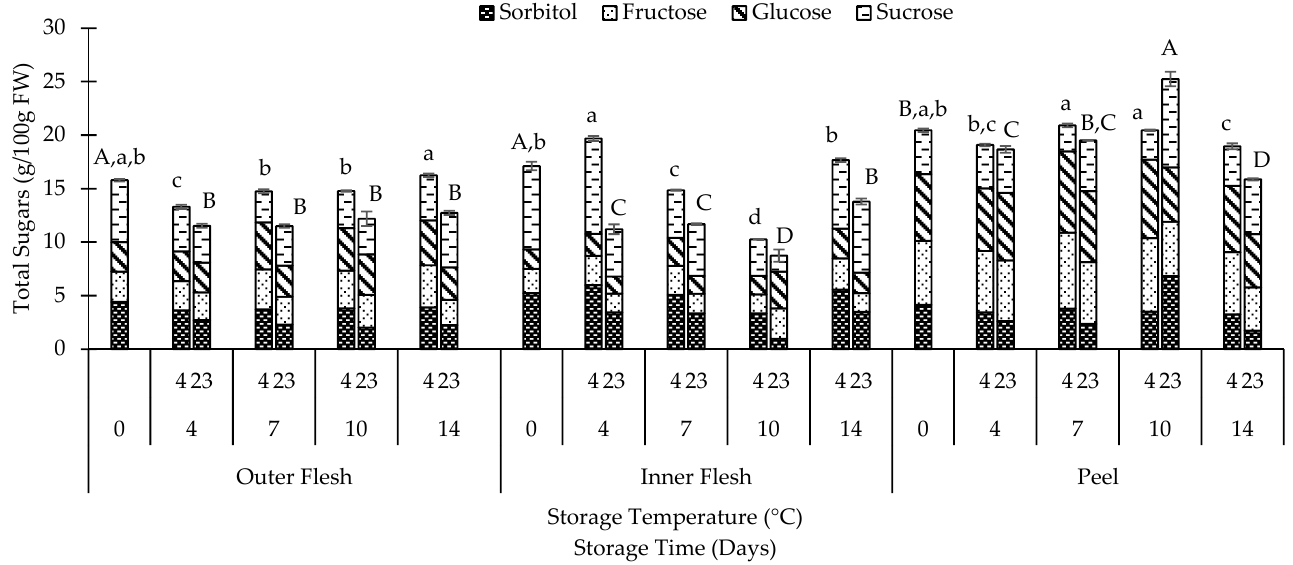
Figure 6. Total sugars (mean ± SE) and individual sugars (mean) in different QGP tissues ( n = 3). Different uppercase letters indicate significant ( p < 0.05) differences between storage days at 23 °C, and different lowercase letters indicate significant ( p < 0.05) differences between storage days at 4 °C.